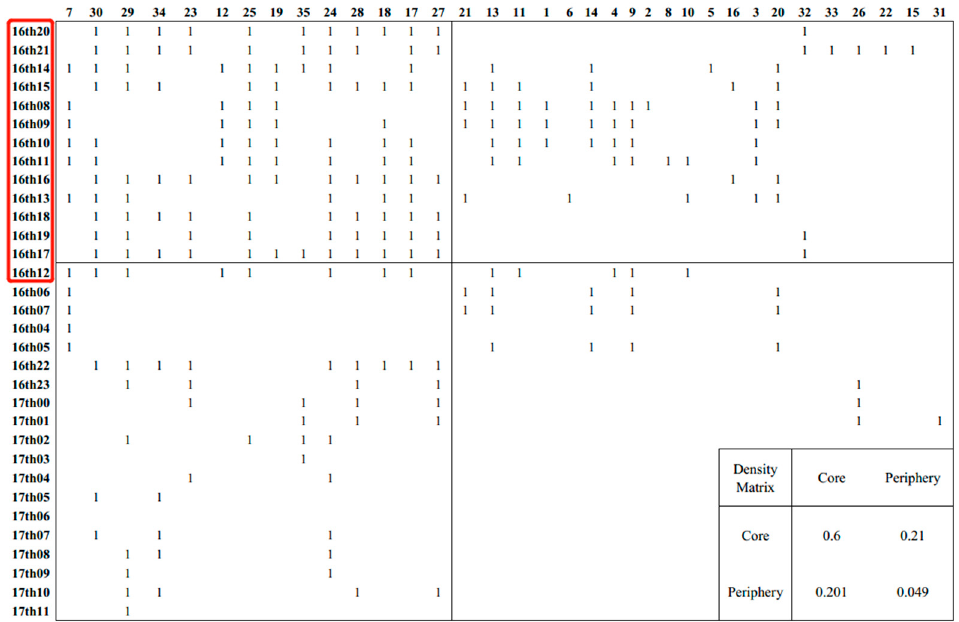
Figure 8. Core–periphery classification matrix of disaster network. Note: There are 13 h in core block that also belong to the “peak time period”.